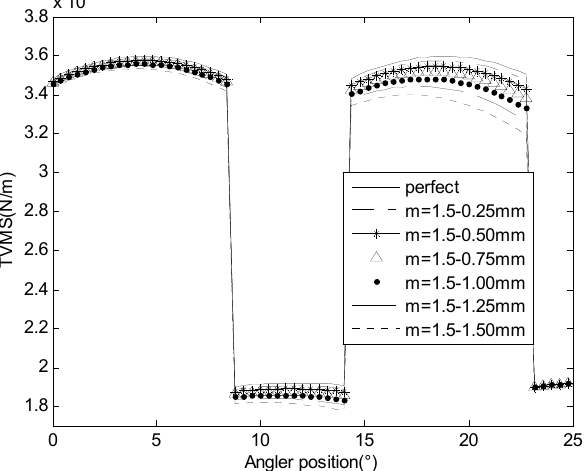
Figure 16. Meshing stiffness for the cracked gear under the 1.5 mm modulus.